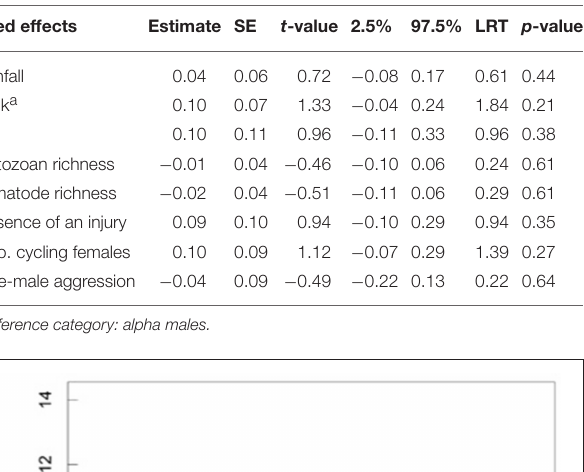
TABLE 3 | Estimates, standard errors (SE) and confidence intervals of fixed effects predicting variations in fecal neopterin concentrations in adult males ( N = 13 individuals and 113 samples; mean number of samples per male ± SD: 8.7 ± 10.1; range: 1–31).